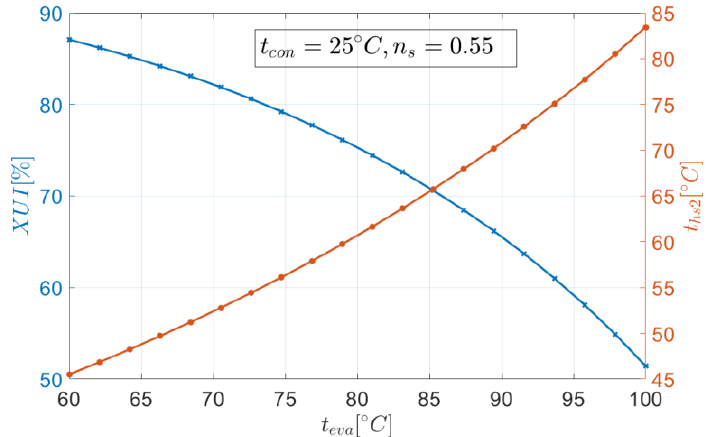
Figure 3. XUI and temperature t hs2 of the heat carrier at the outlet of vapor generator as functions of evaporation temperature t eva.